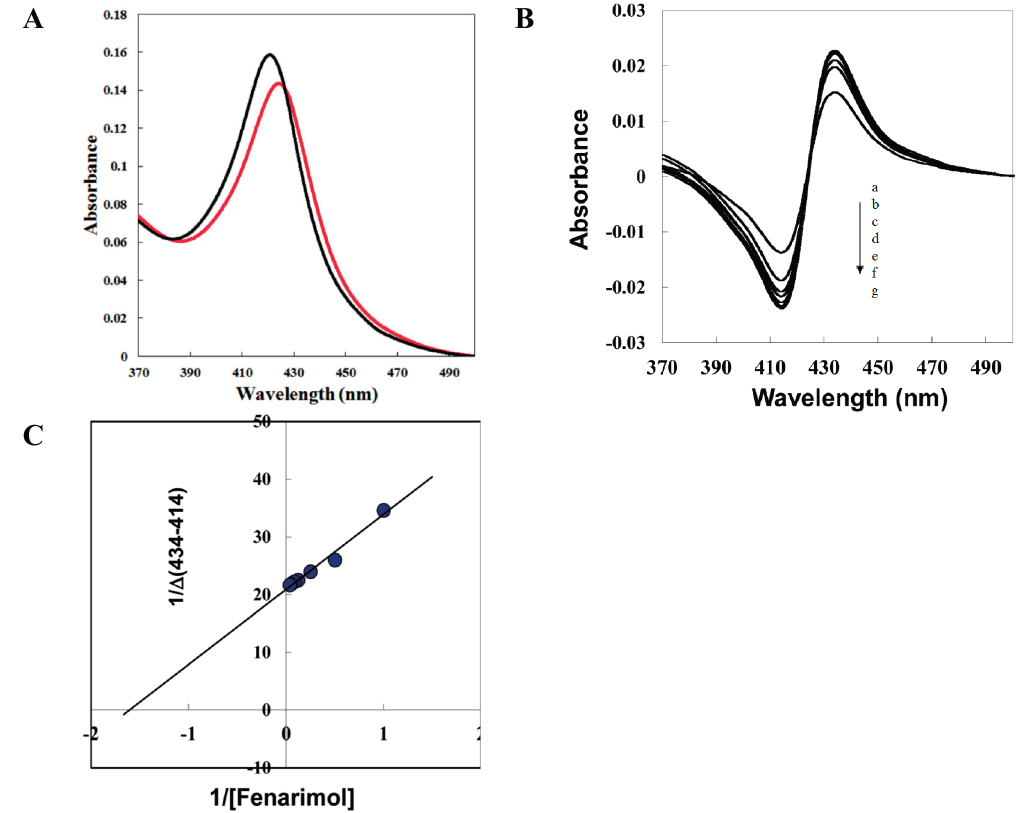
Figure 7. Binding of fenarimol to CYP90D1. ( A ) Absorption spectra of oxidized CYP90D1 (black line) and its fenaromol complex (red line). Recombinant CYP90D1 (3.5 μ M) was dissolved in 50 mM NaH 2 PO 4 (pH 7.0) with 0.1% Tween 20 containing 20%